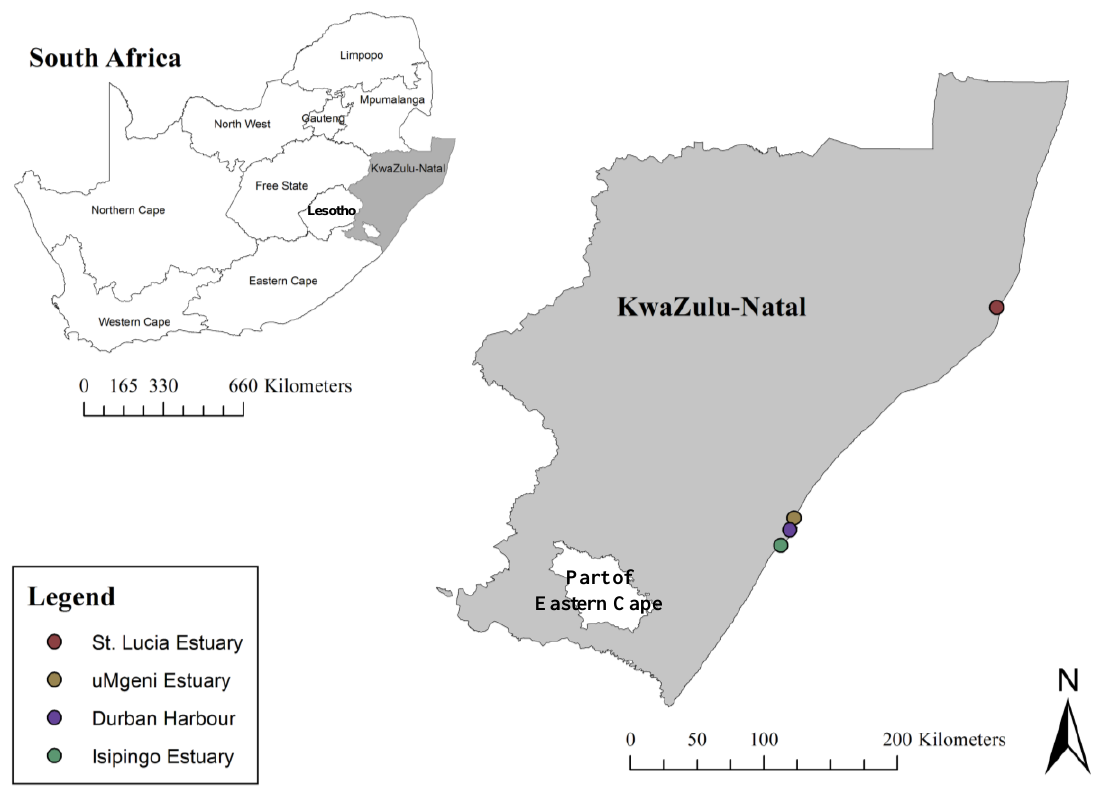
Figure 1. Geographical position of study sites in KwaZulu-Natal, South Africa.